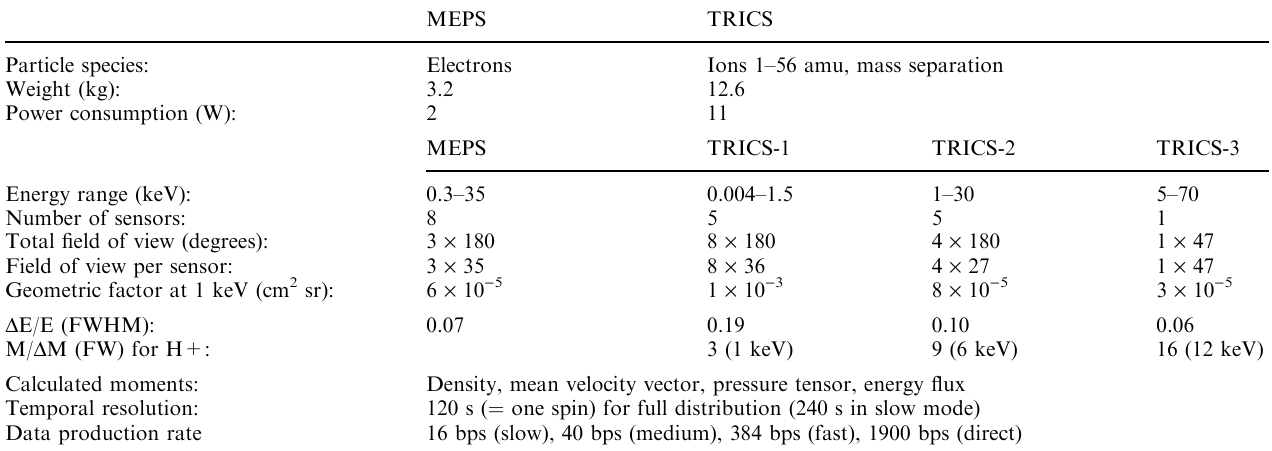
Table 1. Summary of PROMICS-3 instrument